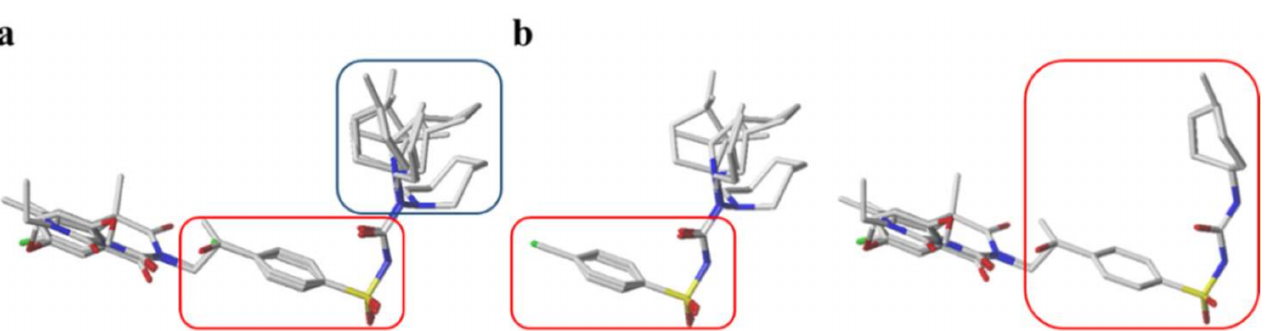
lower part of the structure common to sulfonylureas and connected by wavy lines.